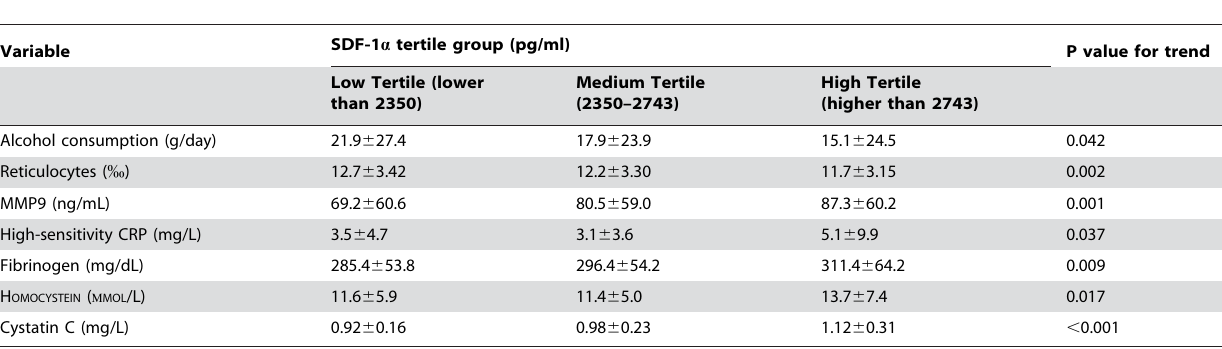
Table 1. Association between SDF-1 a level and selected vascular risk factors and laboratory parameters (2005).